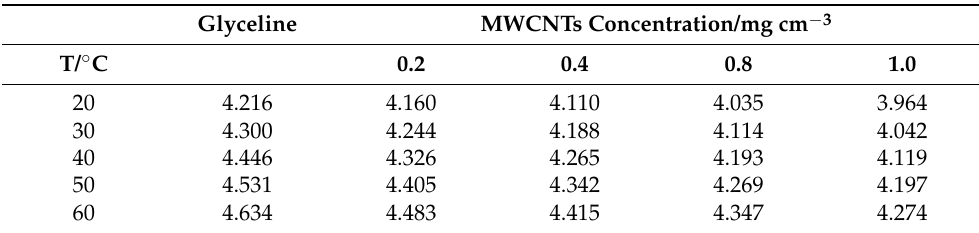
Table 7. Average hole size (Å) according to the hole theory for pure glyceline and several dispersions prepared with increasing concentration of MWCNTs at different